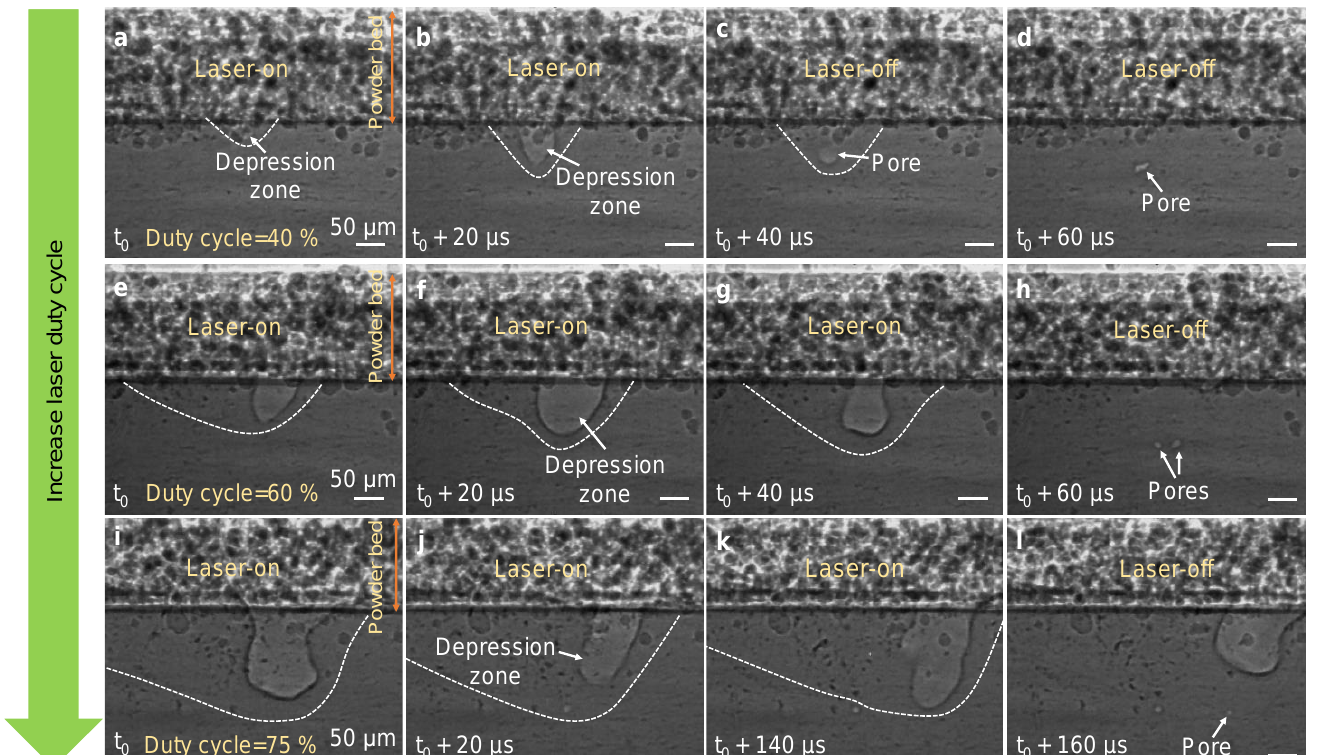
Figure 3. Pore formation under varying laser duty cycles at a constant laser frequency: ( a – l ) Dynamic X-ray images showing pore formation during the PW-LPBF process of Al6061 at the laser duty cycle of 40% ( a – d ), 60% ( e – h ), and 75% ( i – l ) at a laser frequency of 7 kHz, a laser power of 470 W and a scan speed of 0.4 m/s. In ( d , h , l ) the melt pool boundary is not indicated to avoid blocking the view of the pores. Note that images do not display the complete duration of one pulse. The compiled movies showing the complete duration of two consecutive pulses are available in the Supplementary Material (Movies S4 – S6).